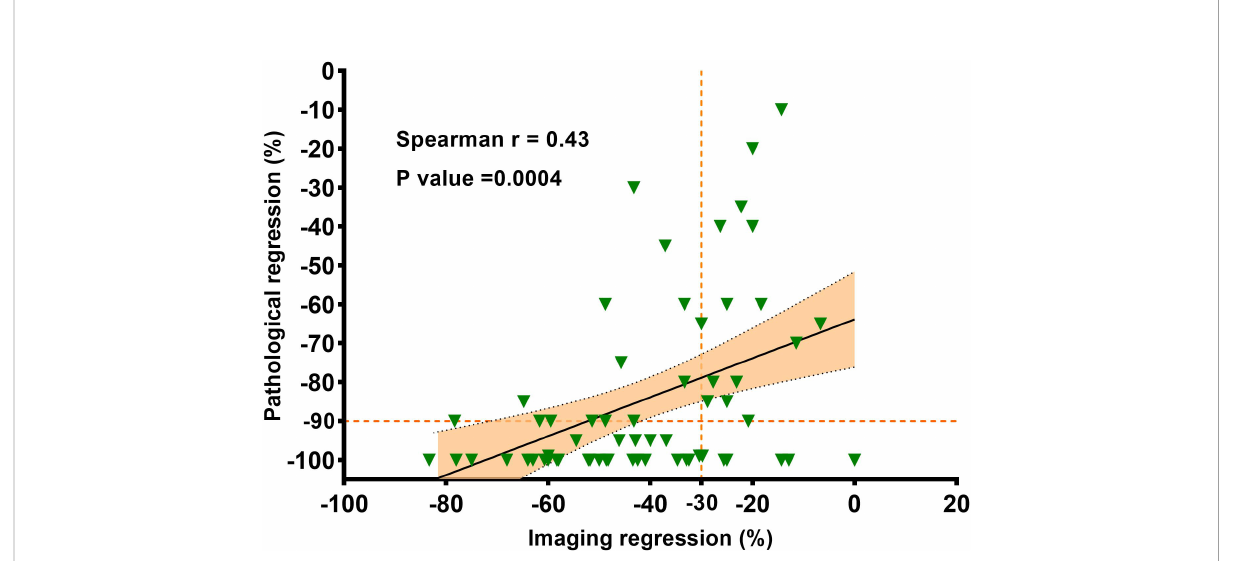
FIGURE 3 The correlation between the imaging regression and the pathologic regression. Pearson correlation coef fi cient and two-sided P value are